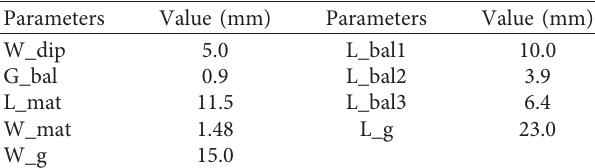
Table 1: Parameters of the dipole unit cell.